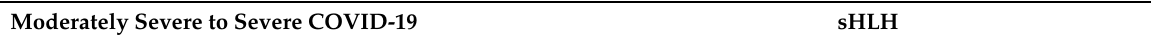
Table 1. Moderately severe to severe COVID-19 as a form of sHLH. sHLH—secondary haemophagocytic lymphohistiocyto- sis; COVID-19—coronavirus disease 2019; HLH—haemophagocytic lymphohistiocytosis; IL-6—interleukin 6. Moderately Severe to Severe COVID-19 sHLH prevalence in pregnant women—rarely diagnosed aetiology viral infection viral infection in most cases hyperferritinaemia marker of poor prognosis in COVID-19